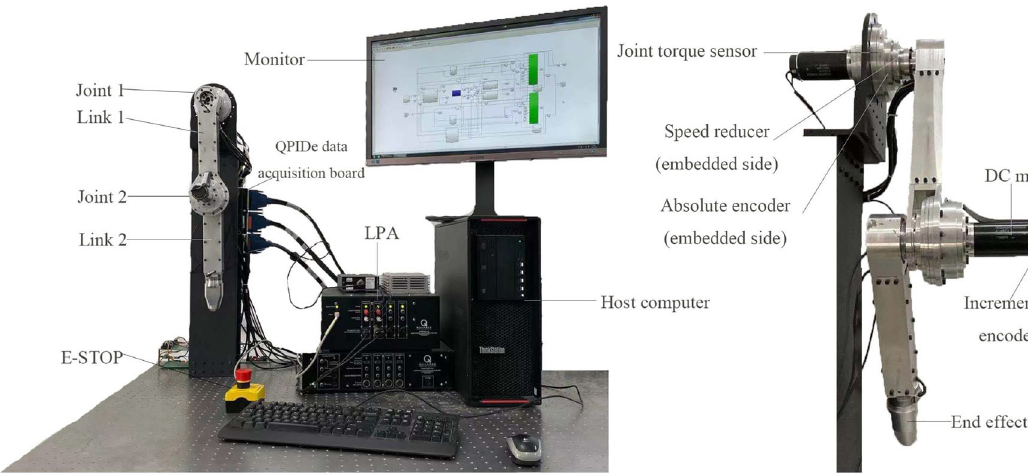
Fig. 3 Experiment platform